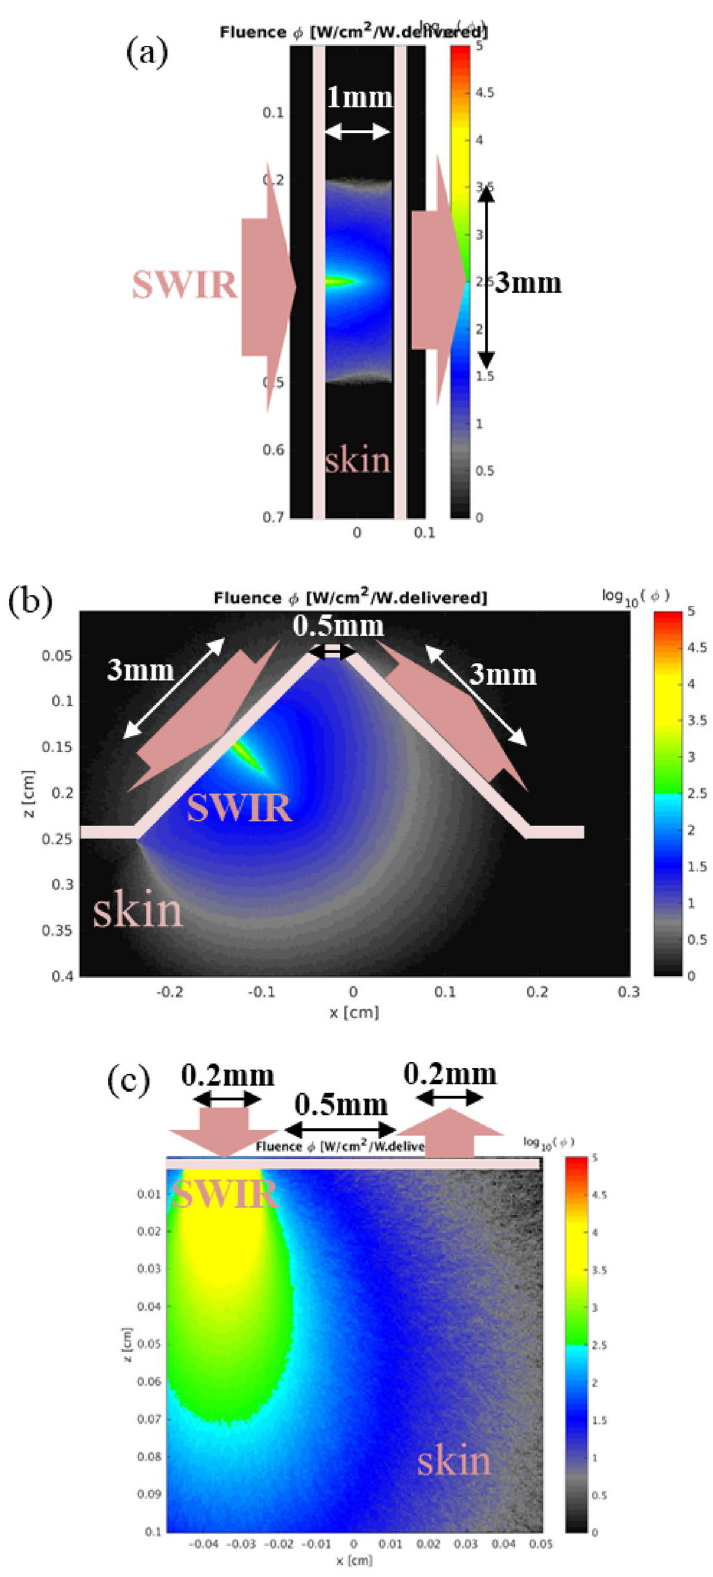
Figure 1. Skin-SWIR optical interaction simulated by MC method for ( a ) transmission, ( b ) transflection and ( c ) reflection optical